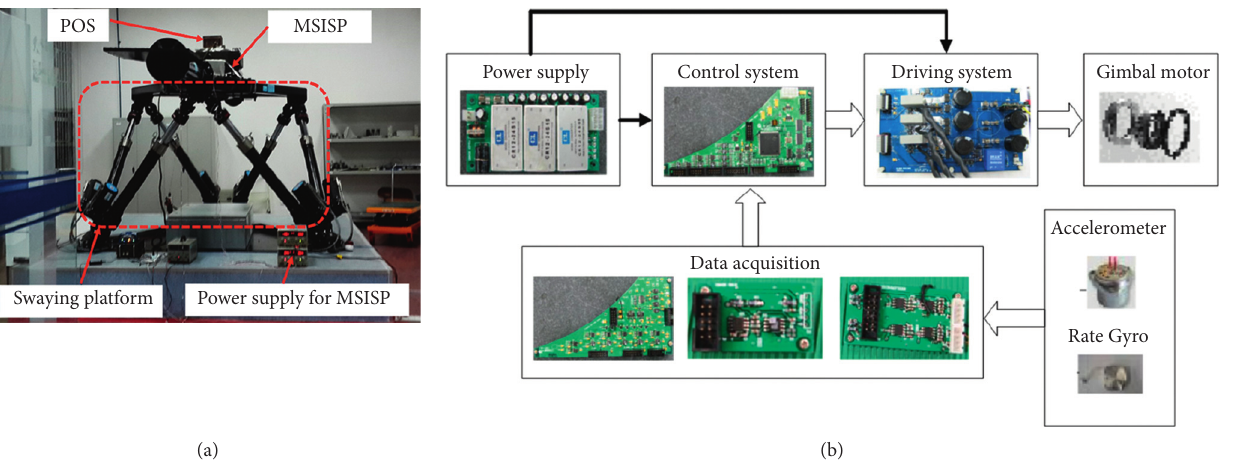
Figure 11: Experimental setup. (a) Experimental system. (b) Control scheme of three-axis